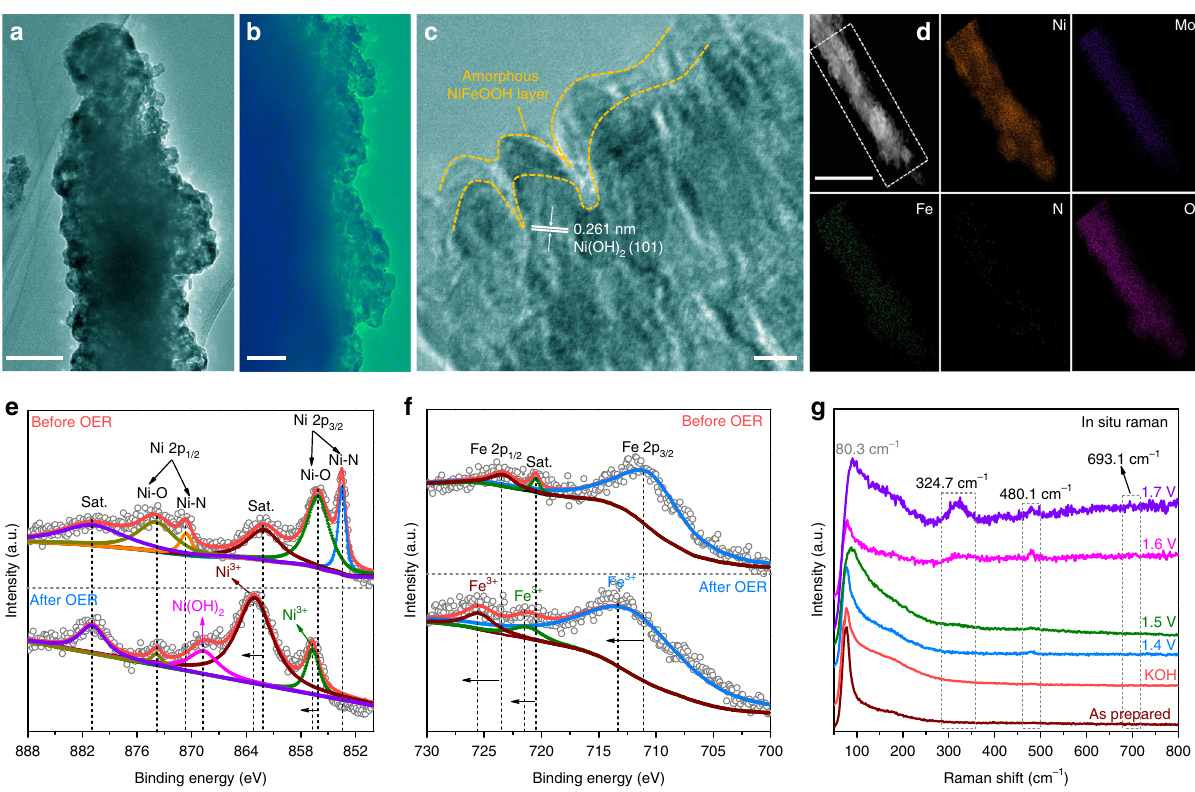
Fig. 5 Material characterization to study the OER active sites. a , b TEM images of NiMoN@NiFeN core-shell nanorods at different magni fi cations after OER tests. c HRTEM image, and d DF-STEM image and corresponding elemental mapping of the NiMoN@NiFeN catalyst after OER tests. Scale bars: a 500 nm; b 50 nm; c 5 nm; d 1 µ m. High-resolution XPS of ( e ), Ni 2p and ( f ), Fe 2p of NiMoN@NiFeN after OER tests in comparison with those before OER tests. g In situ Raman spectra of the NiMoN@NiFeN catalyst at various potentials for the OER